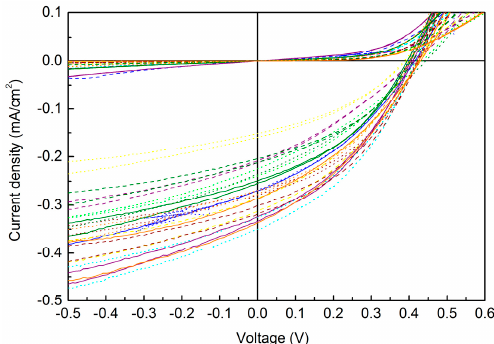
Figure 6. Graph showing the current versus voltage electrical characteristics of the all inkjet-printed OPVs with 17.5 mm 2 as an active area.